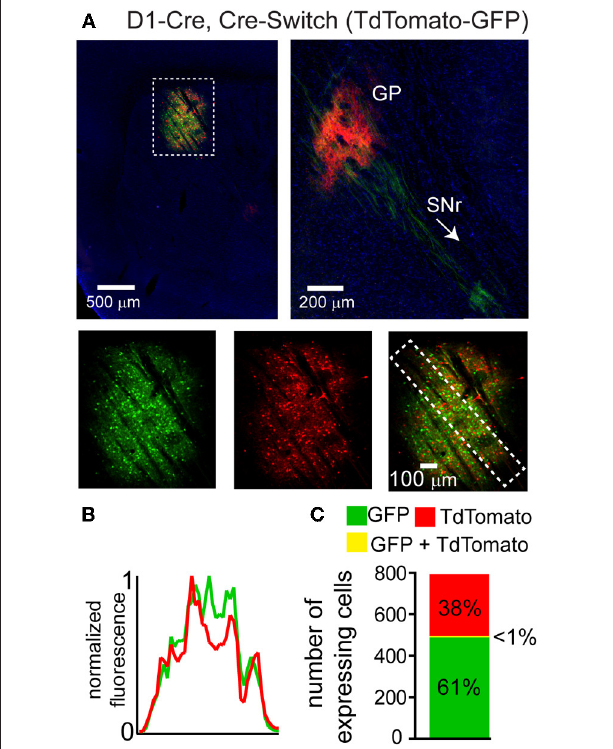
FIGURE 3 | A single orientation switching transgene can mediate Cre-On and Cre-Off expression without spatial interference. (A) Left , Sagittal section through a D1-Cre mouse infected with a Cre-Switch transgene encoding Cre-Off TdTomato and Cre-On GFP in the striatum. Right , more medial section containing the GP and both TdTomato + and GFP + projections. Bottom , GFP and TdTomato fluorescence is spatially intermingled. (B) Normalized mean fluorescent values for GFP and TdTomato quantified from boxed inset in A, bottom right . (C) Confocal imaging through the infection volume ( N = 3 infections, N = 796 cells) revealed that GFP ( N = 489 cells) and TdTomato ( N = 302 cells) were expressed in largely non-overlapping cell populations ( N = 7 / 791 cells were double-positive for GFP and